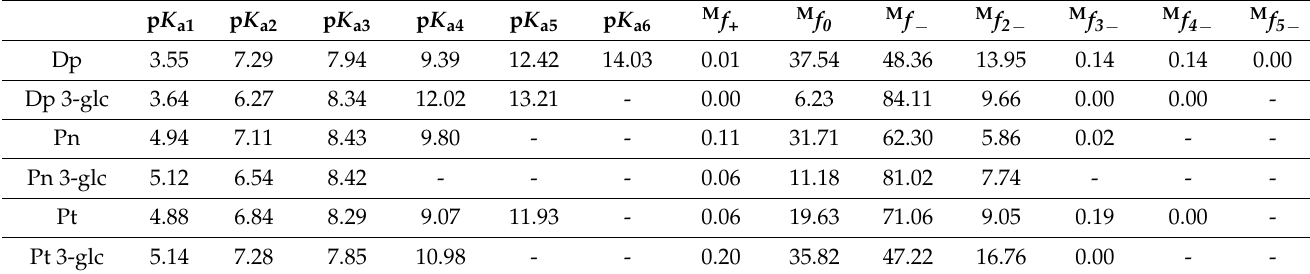
Table 2. Dissociation constants ( pK a ) and molar fractions ( M f ) in %, of the species of each compound under investigation, at pH =